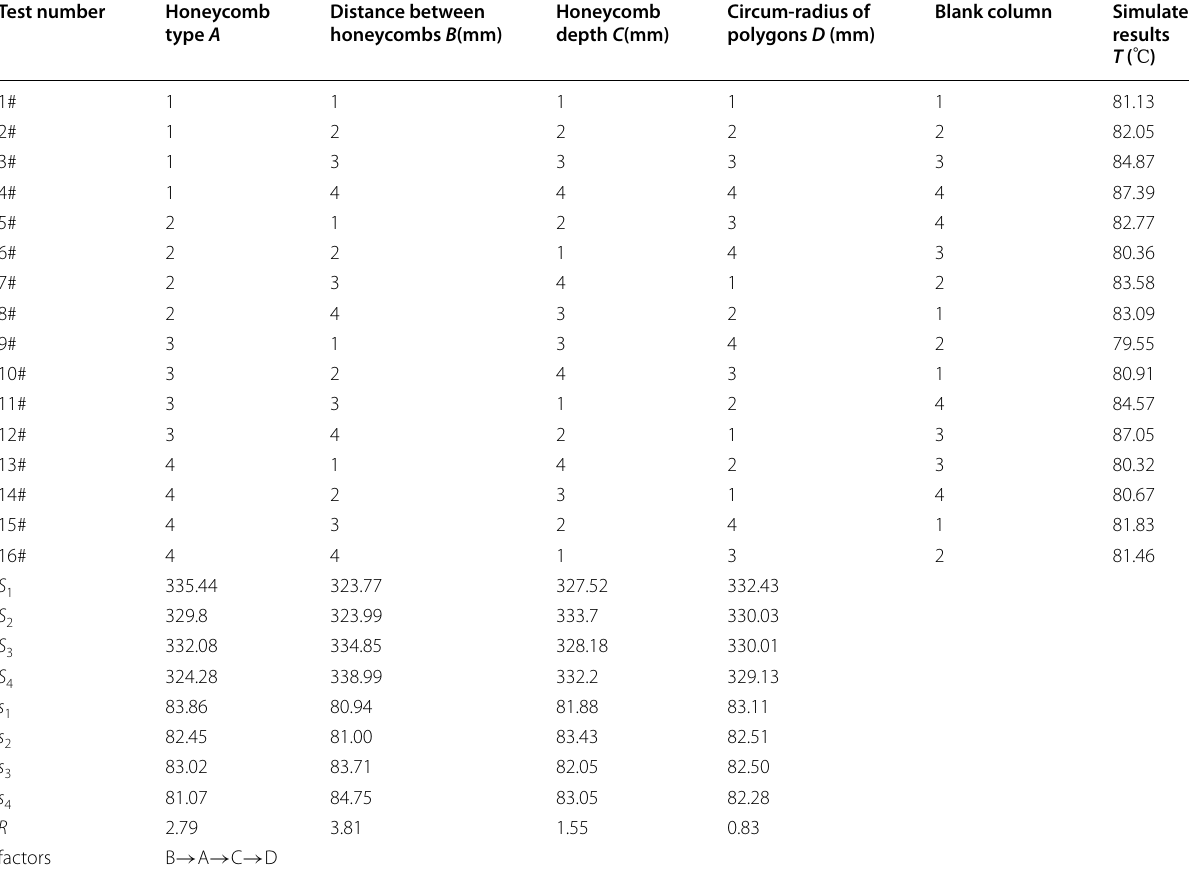
Table 3 The results of orthogonal